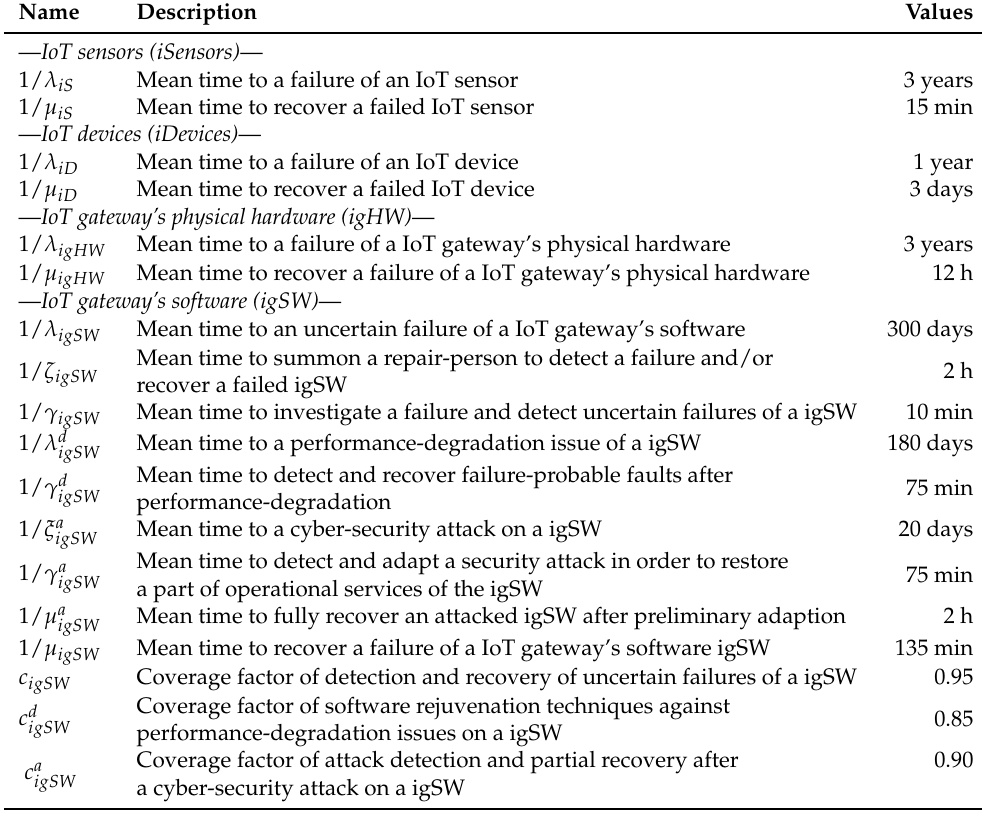
Table 3. Default input parameters for models of a fog member system.